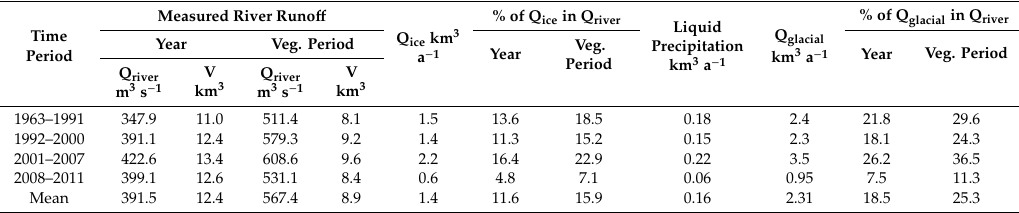
Table 10. Change in the share of total glacier runo ff in the Ile river runo ff at the Yamadu station. Q gl —runo ff from melting of multiyear ice; Q gr —total glacier runo ff ; Veg. period—vegetative period between May and